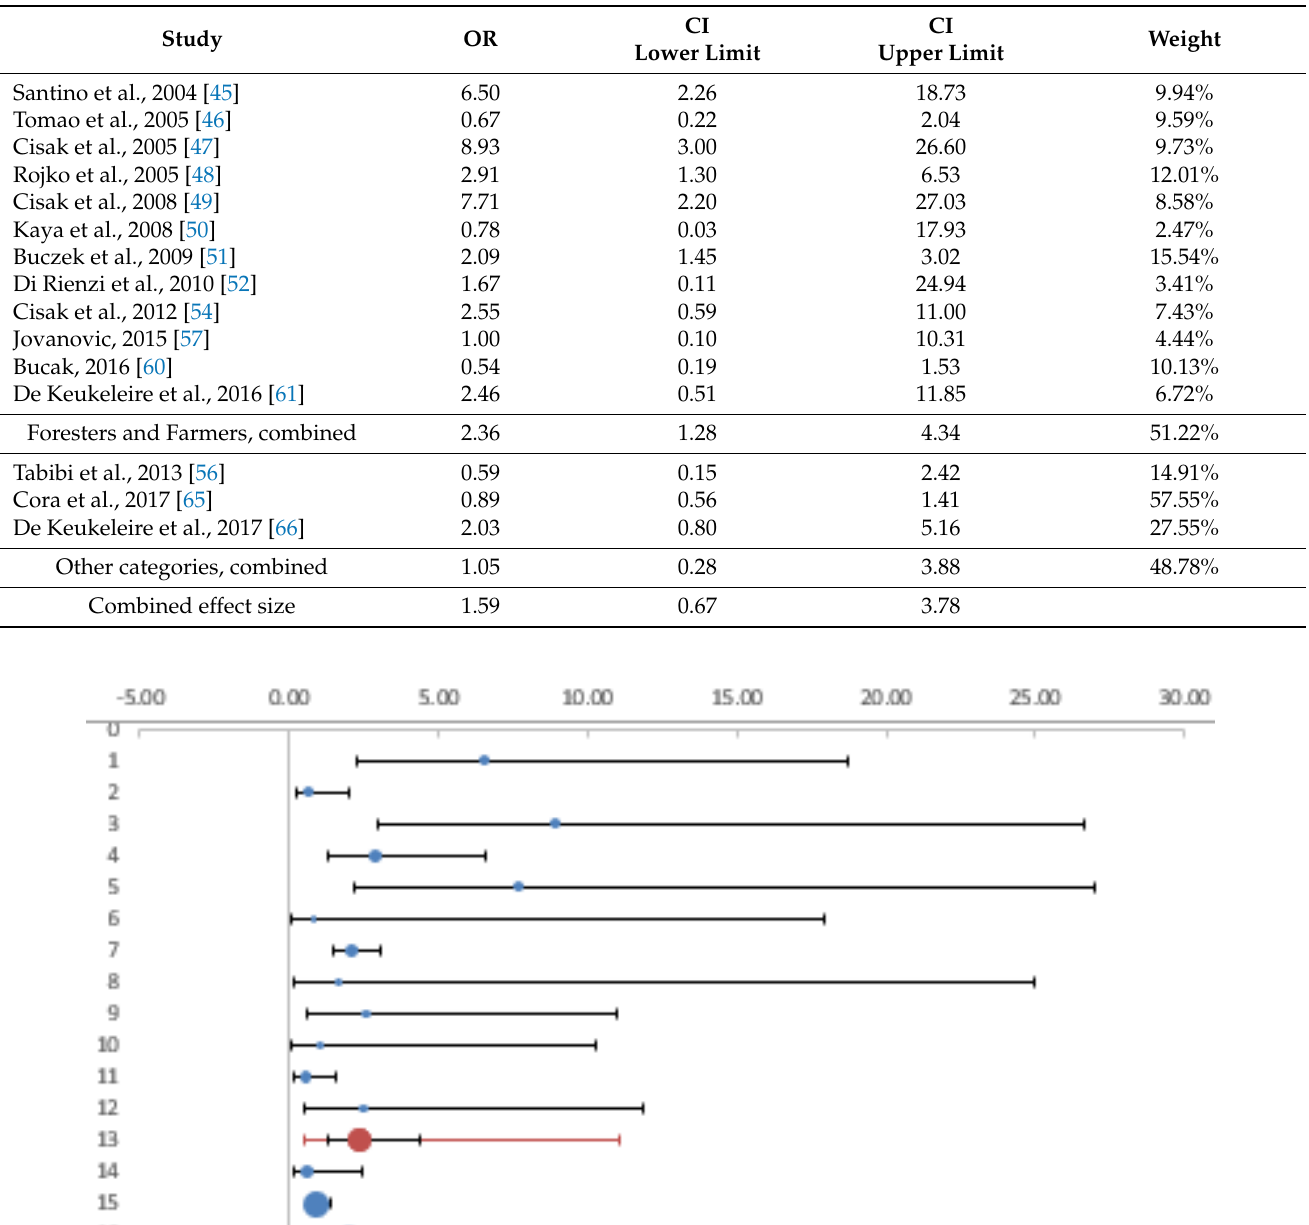
Table 3. Comparison of Forester and farmers with other categories of exposed workers.